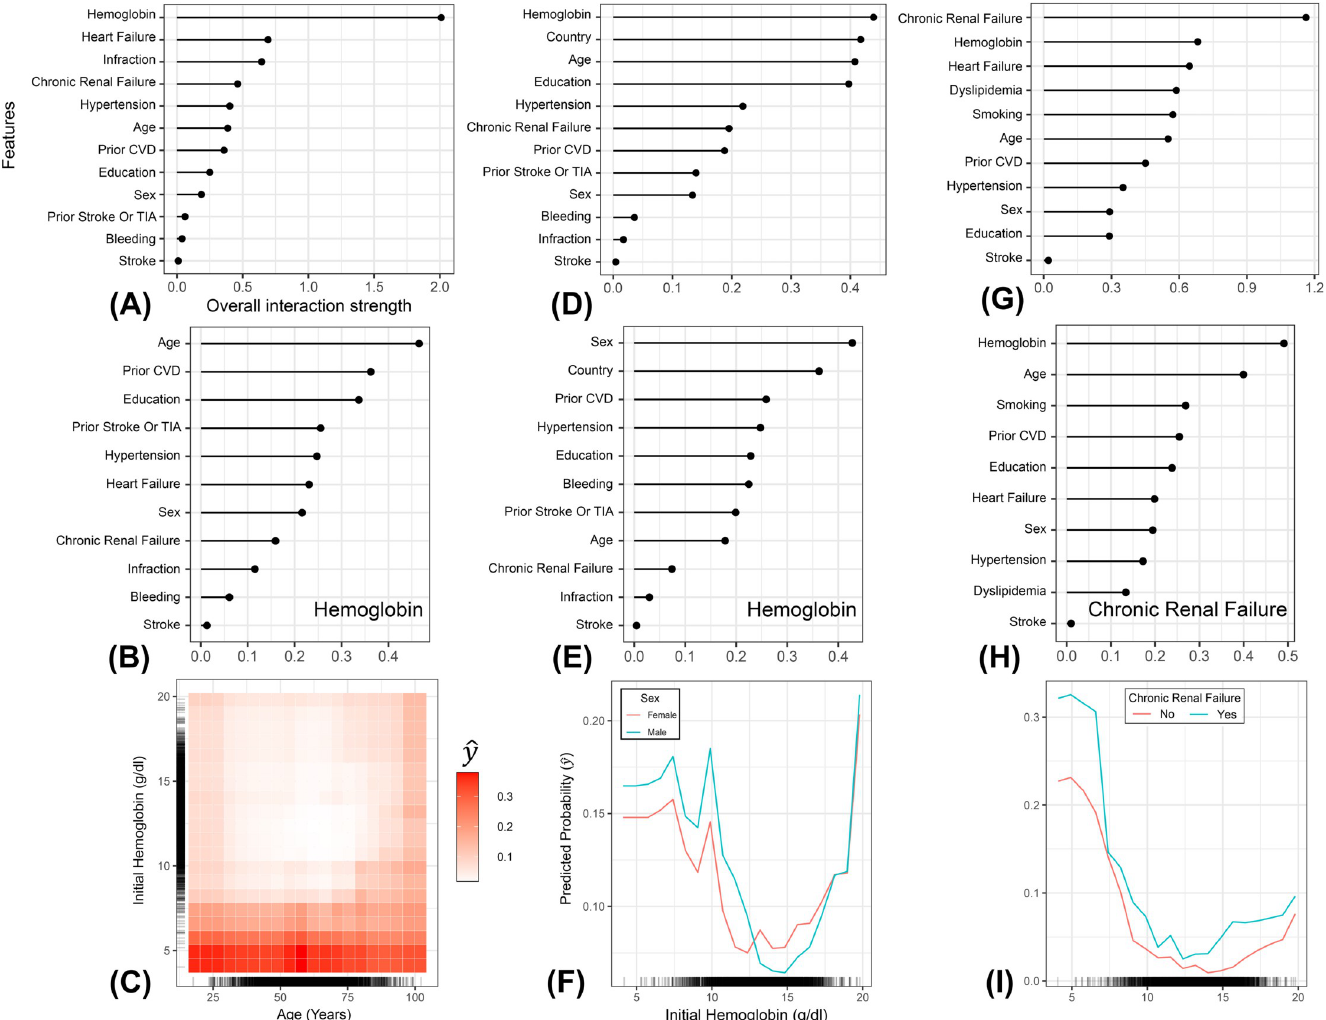
Fig 3. Feature interaction plots calculated using Friedman’s H-statistic. (A-C) indicate the mortality model; (D-F) indicate the heart failure model; (G-I) indicate the bleeding model. The three plots on the top (A, D, G) showing the overall interaction strength of each feature with the other features. Plots (B & E) demonstrates the overall interaction strength of hemoglobin with the other features, while plot (H) demonstrate the overall interaction strength of chronic renal failure with the other features. Partial dependence plots at the bottom (C, F, I) represent the top interactions that shaped the risk of the three acute coronary syndromes outcomes. (C) interaction between age and initial hemoglobin for the mortality model. The heat matrix corresponds to the risk of death, in which lighter shades of red indicate lower risks of death, and darker shades of reds indicate higher risks of death. The bar on the right indicates (y hat) the relative risk of being dead with all other feature combinations marginalized. (F) interaction between sex and initial hemoglobin for the heart failure model. (I) interaction between chronic renal failure initial hemoglobin for the bleeding model. Red and green partial dependence curves represent different sexes (F) and the status of chronic renal failure (I), while the y-axis indicates the predicted risk of heart failure or bleeding. CVD: Cardiovascular disease. TIA: Transient ischemic attack.